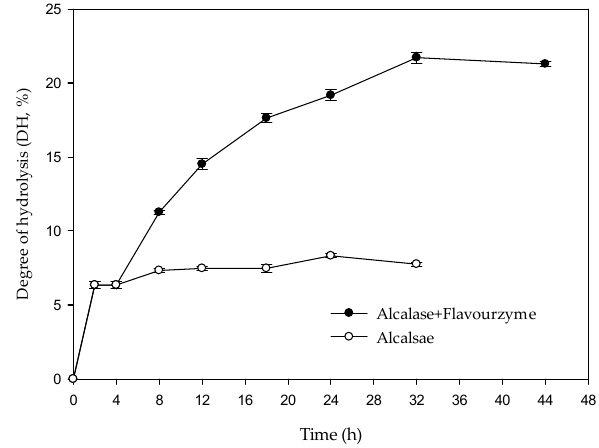
Figure 1. The degree of hydrolysis (DH) of whey protein hydrolysates during two-stage hydrolysis using alcalase and flavourzyme.